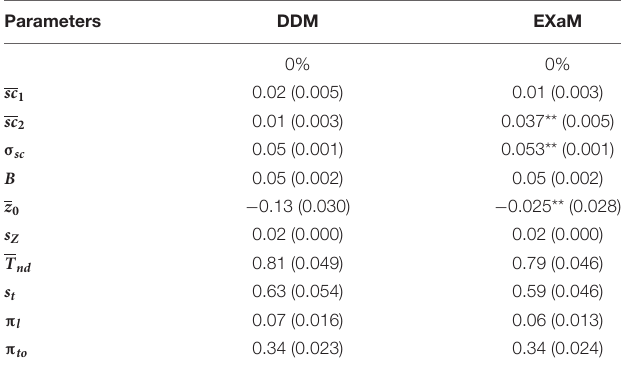
TABLE 1 | Mean of the average posterior parameter distributions for the DDM and EXaM for 0% coherence across 44 participants. Parameters